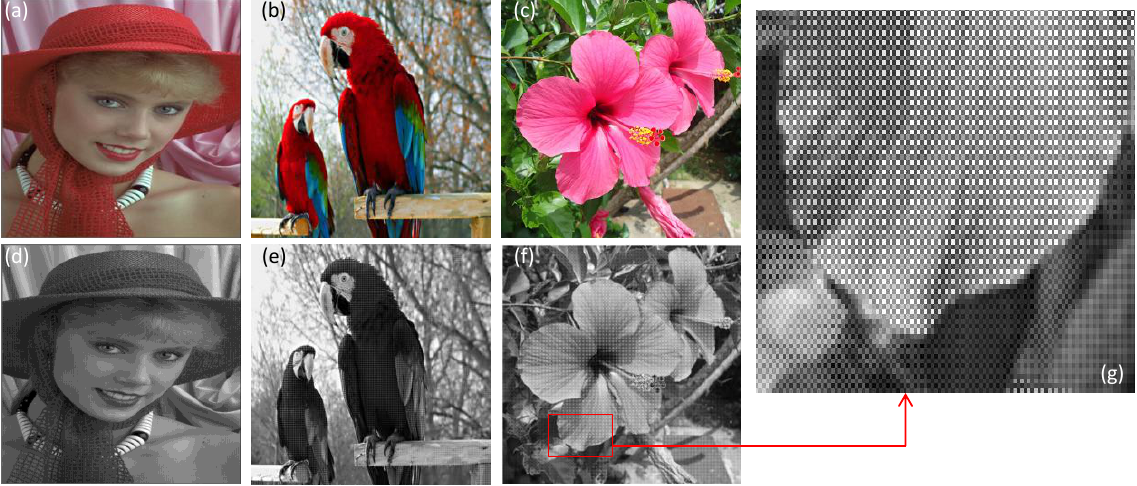
Figure 9. Non-authorized (false class) multispectral images and the correspoding down-sampled Bayer images ( a ) Non-authorized image (false class I); ( b ) Non-authorized image (false class II); ( c ) Non-authorized image (false class III); ( d ) Down-sampled Bayer image of the false class I; ( e ) Down-sampled Bayer image of the false class II; ( f ) Down-sampled Bayer image of the false class III; ( g ) The enlarged Bayer image for portion of image (f).